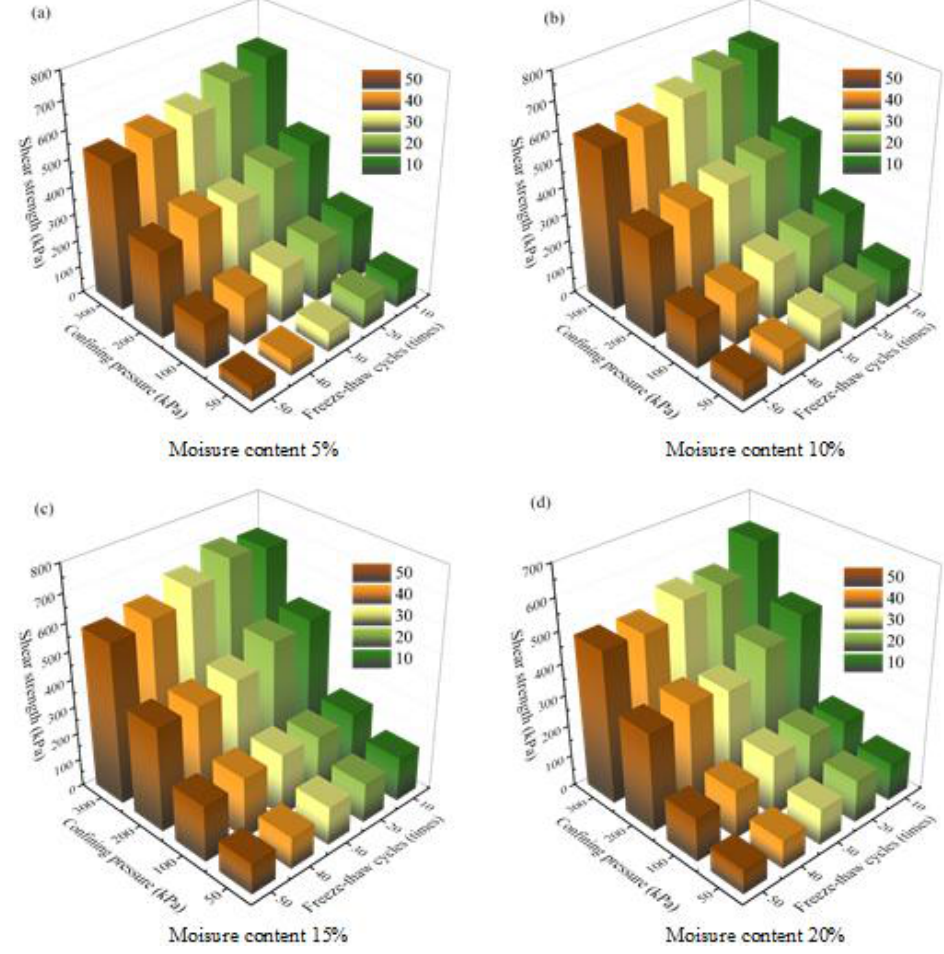
Figure 3. Shear strength of tailings under different freeze–thaw cycles: ( a ) Moisture content 5%; ( b ) Moisture content 10%; ( c ) Moisture content 15%; ( d ) Moisture content